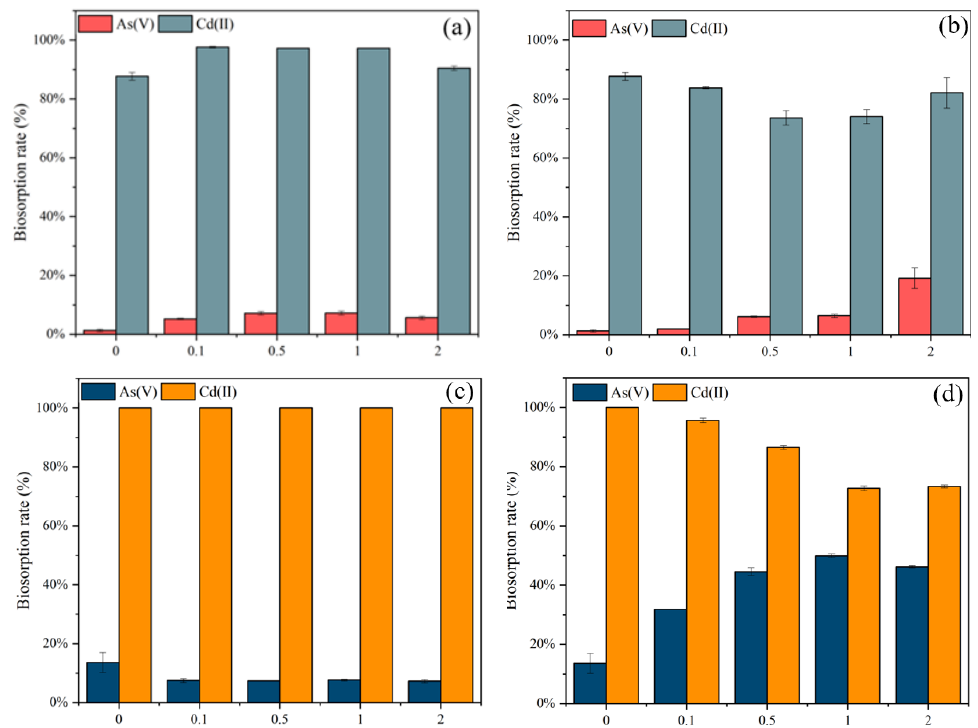
Figure 3. Biosorption rates (%) for As(V) and Cd(II) by different concentrations of ( a ) NaCl and ( b ) ZnCl 2 modified C. vulgaris , and ( c ) NaCl and ( d ) ZnCl 2 modified S. platensis .